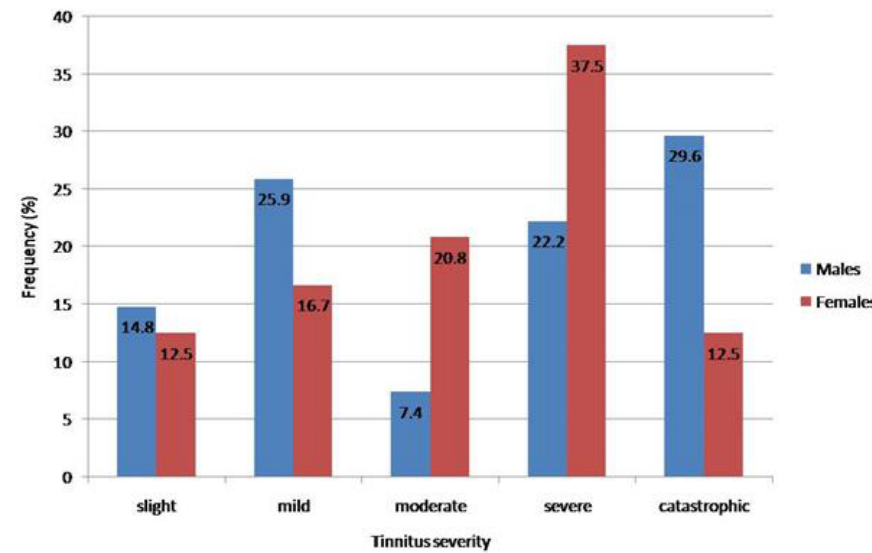
Figure 1. Frequency of tinnitus severity levels in males (blue) and females (red).